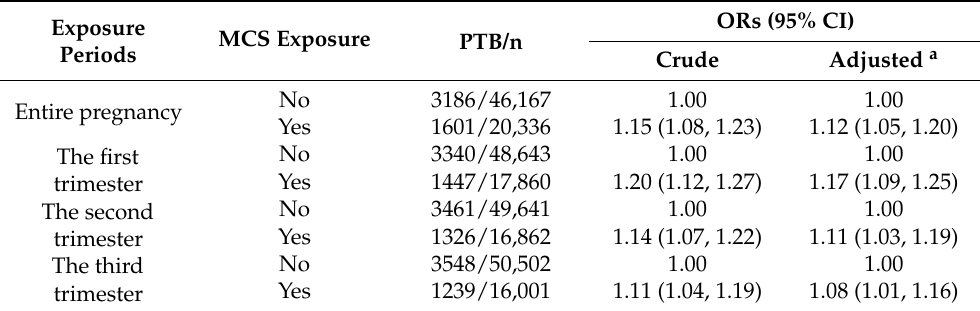
Table 2. Associations between maternal MCS exposure during different periods of pregnancy and